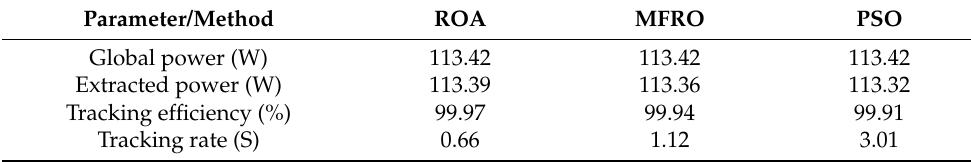
Table 4. Numerical results of the ROA, MRFO, and PSO methods in pattern